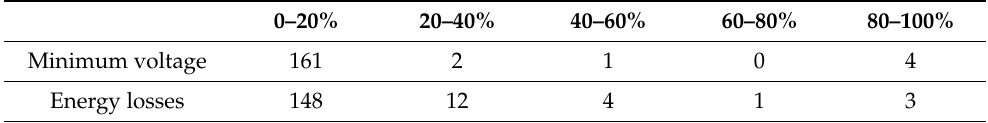
Table 8. AMD of the values obtained (5% variation in demand).